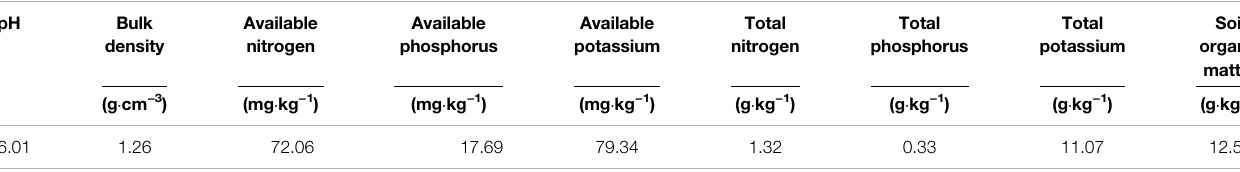
TABLE 1 | Soil basic physicochemical property.